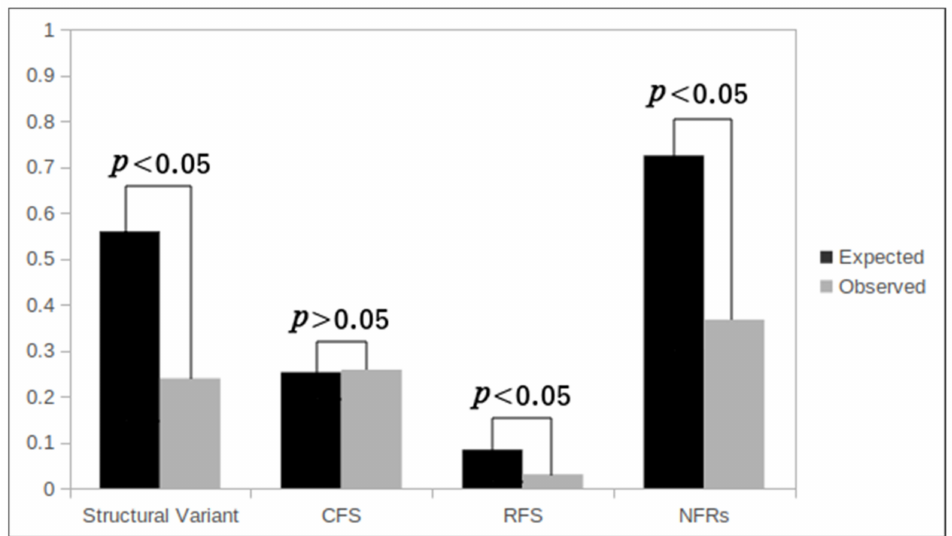
Figure 3. Summary of the EBV-IS distribution. Distribution of 453 out of 459 EBV-IS, that could be precisely assigned to a cytoband, in the chromosomal breakpoints (structural variants), in the common fragile sites (CFS), in the rare fragile sites (RFS), and in non-fragile sites (NFR). The expected EBV-IS (grey bars) and the observed EBV-IS (black bars) ratios of integration of EBV were calculated assuming a uniform, random distribution. p values were calculated by a binomial exact